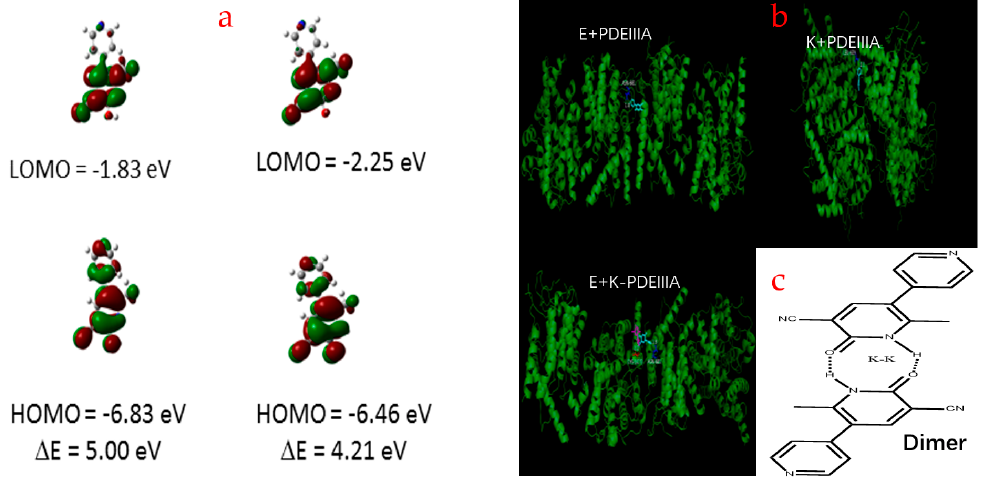
Figure 6. Frontier molecular orbitals (HOMO and LUMO) of the two tautomeric forms of MLR with the energy level ( a ), molecular docking of enol/ketotautomers to PDEIIIA ( b ) and the pattern of the dimers of MLR ( c ).